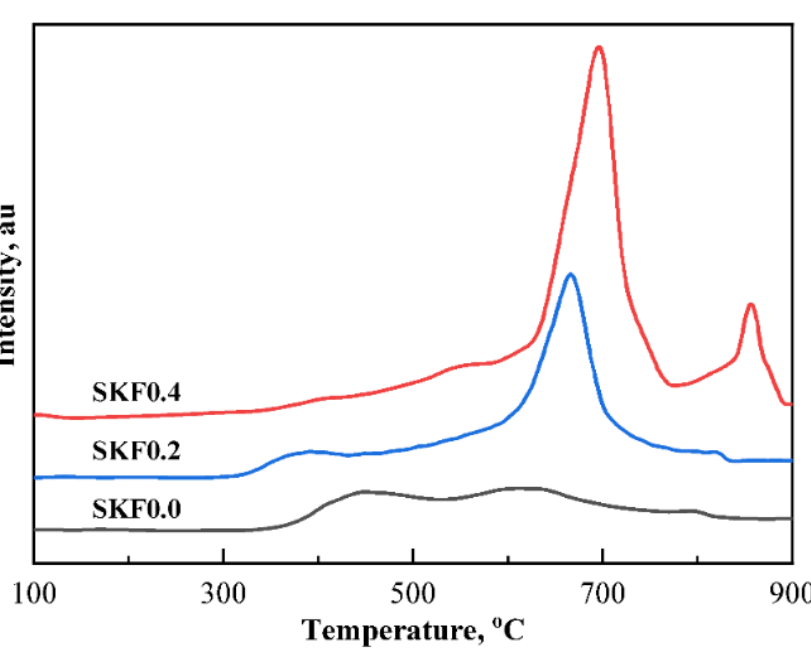
Figure 5. CO 2 -TPD profiles of SKFx (x = 0, 0.2, 0.4, 0.6) perovskite catalysts.